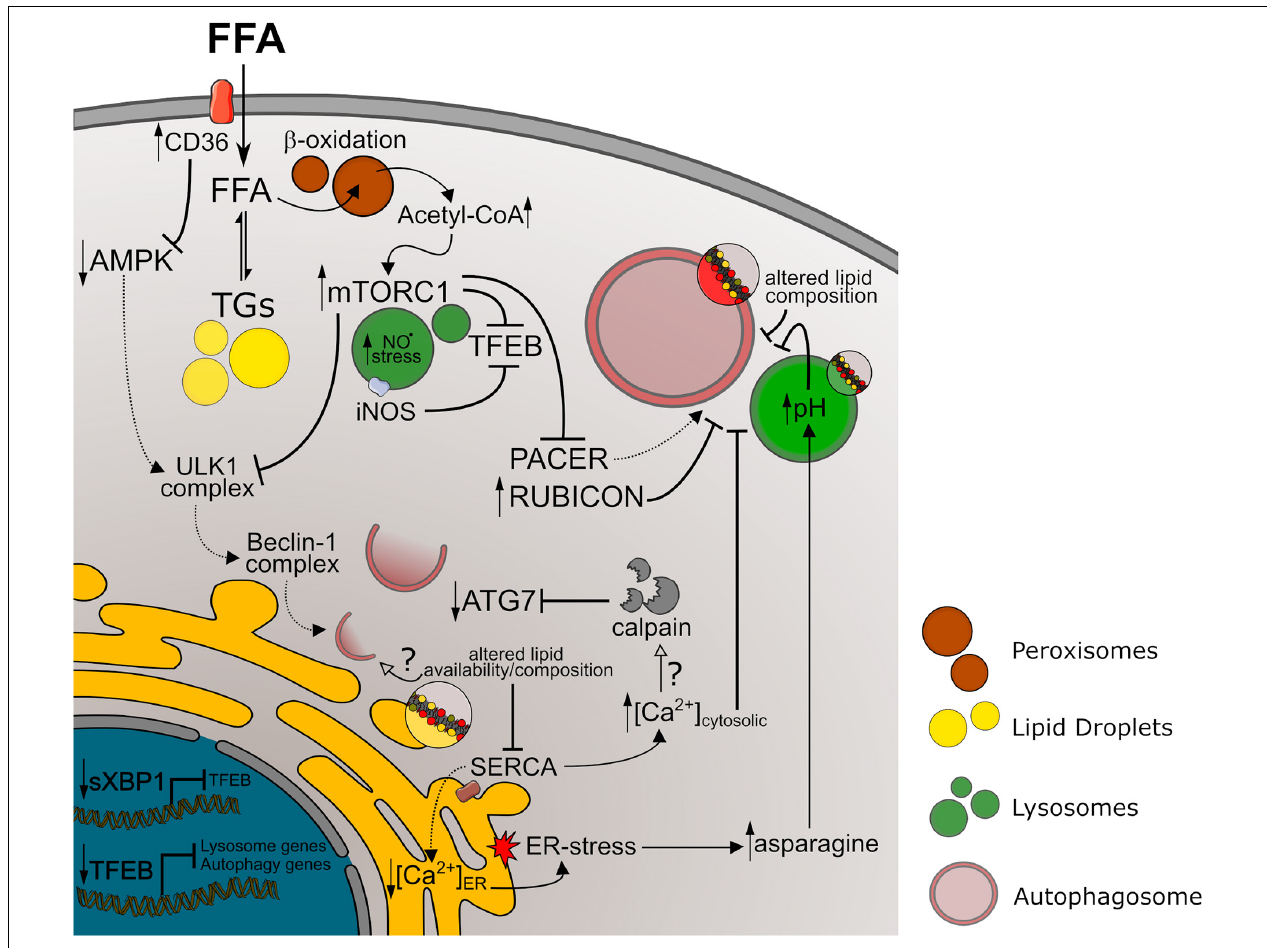
FIGURE 2 | Autophagy impairment in NAFLD models. References to the mechanism represented above are discussed in Section “Mechanisms of Autophagy Impairment in NAFLD” of this manuscript. Longer arrows indicate activation mechanisms, while doted lines or full lines indicate downregulated or upregulated pathways, respectively. Crossed lines indicate inhibitory mechanisms. Small arrows pointing up or down indicate increased or decreased levels/activity, respectively. Unfilled arrows along with question marks indicate hypothetical mechanisms. FFA, free fat acids; TGs, triglycerides; NO · , nitric oxide; ER, endoplasmic